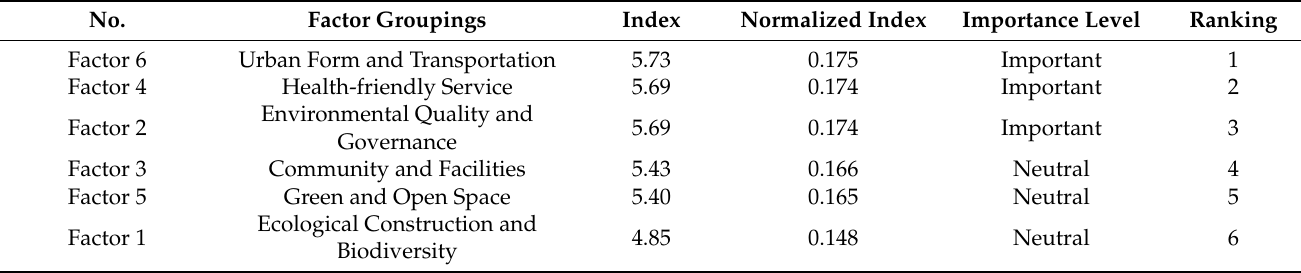
Table 3. Indices and importance levels for all